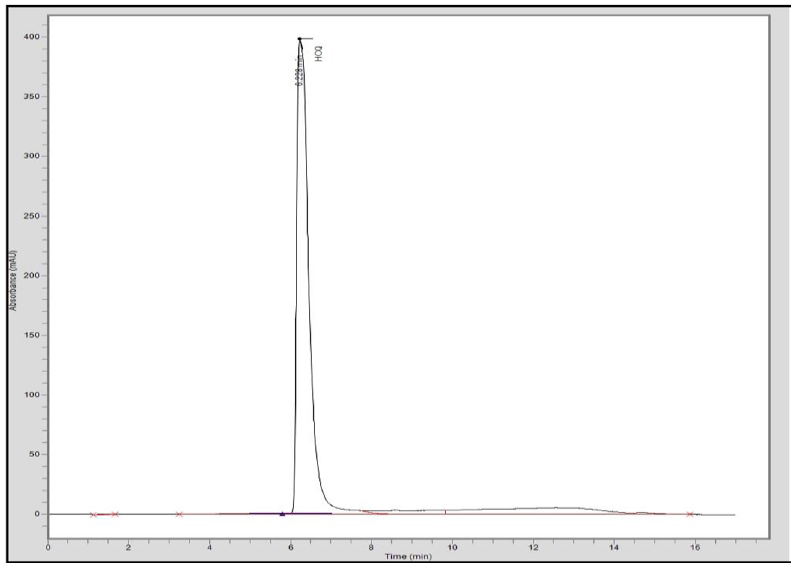
Figure 1: Chromatogram of HCQ reference solution in water at 0.5